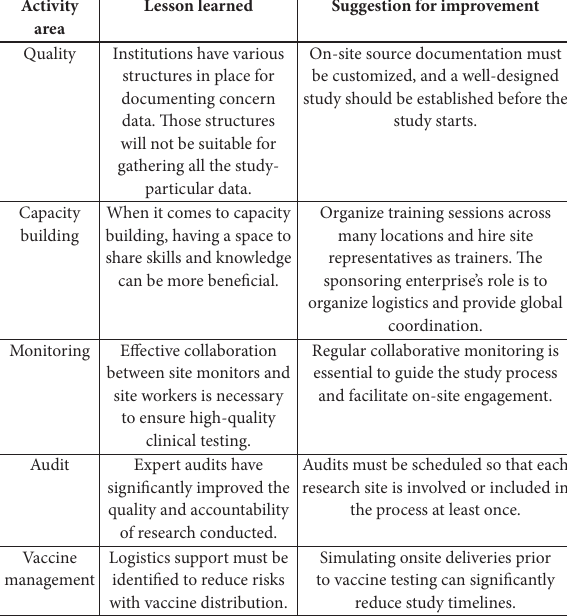
Table 2. Main lessons learned and suggestions for